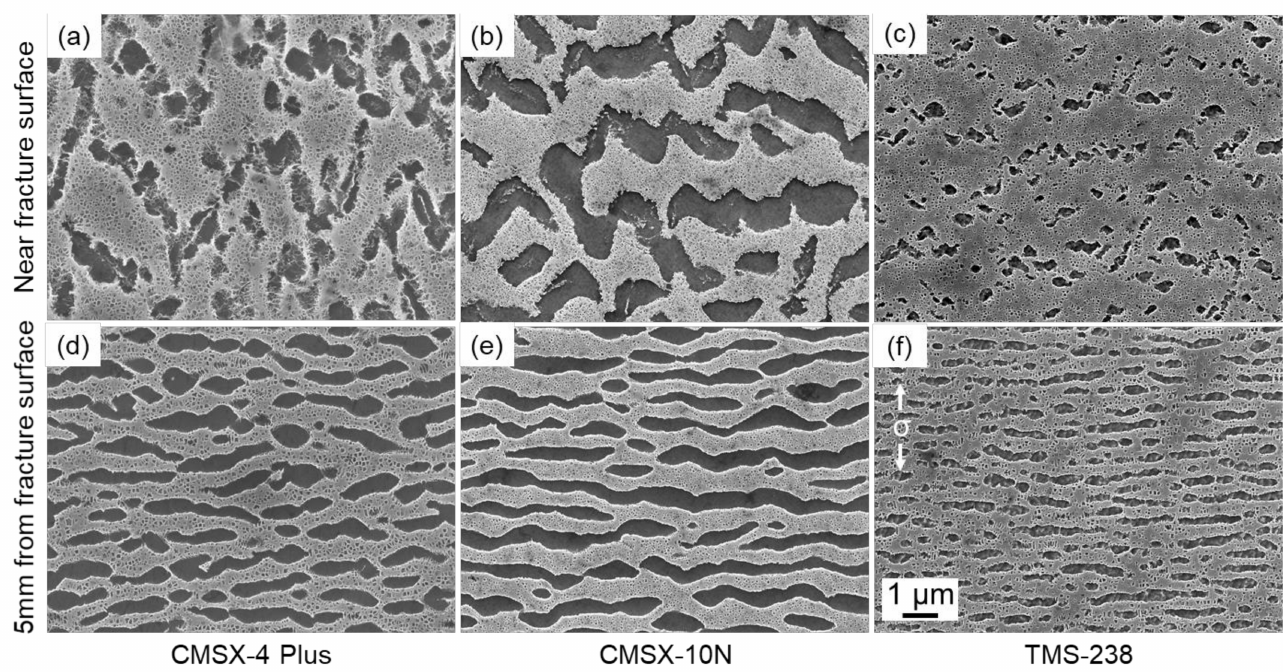
Figure 12. Microstructures after creep rupture tests on CMSX-4 Plus at 1250 ◦ C/110 MPa ( a , d ), CMSX-10N at 1250 ◦ C/110 MPa ( b , e ), and TMS-238 at 1250 ◦ C/100 MPa ( c , f ). ( a – c ) Near fracture surface and ( d – f ) 5 mm from the fracture surface.